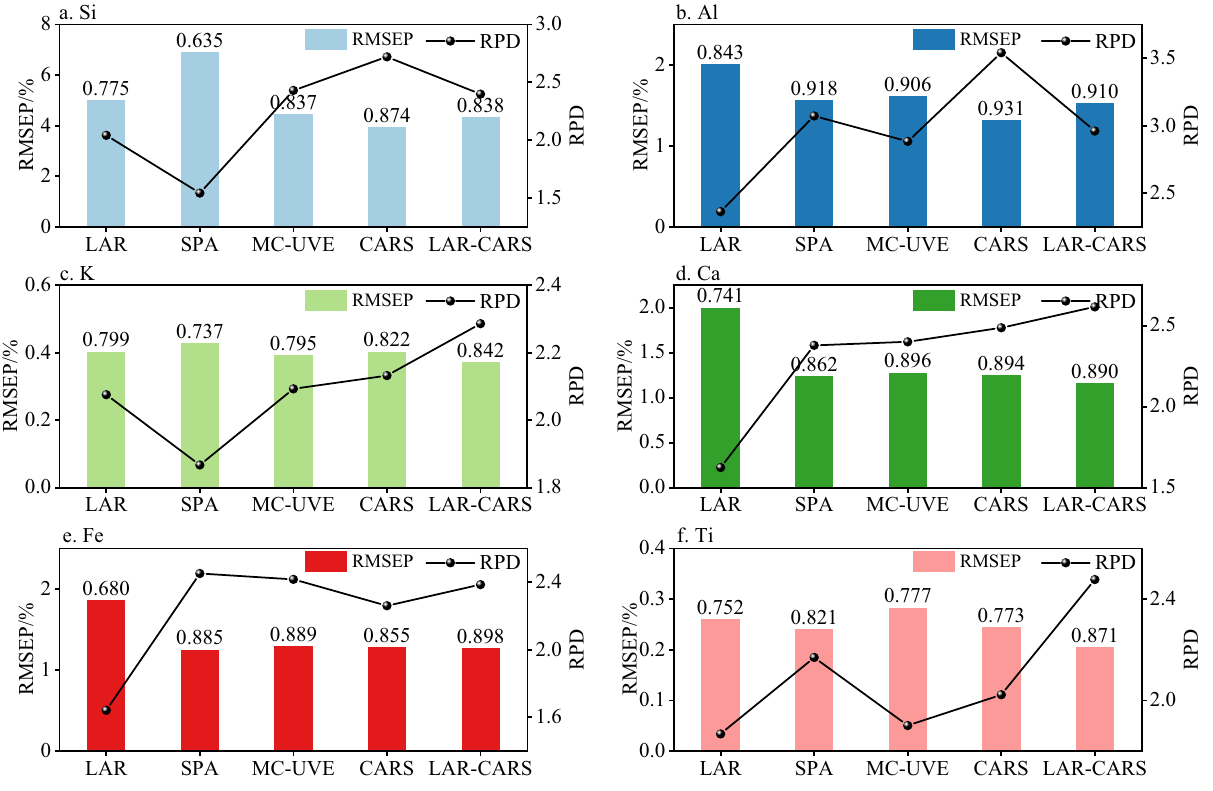
Figure 8. XGBoost modeling effect of validation set, ( a ) Si, ( b ) Al, ( c ) K, ( d ) Ca, ( e ) Fe, ( f ) Ti. *The bar chart is labeled R 2 for this model.